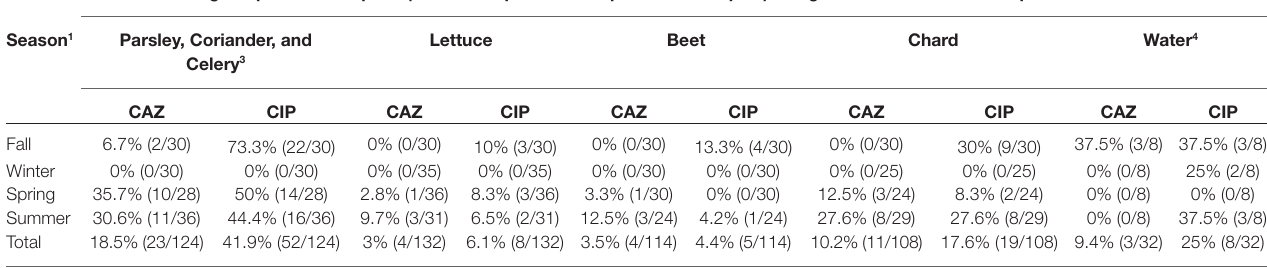
TABLE 1 | Prevalence of Enterobacterales detected with ceftazidime and ciprofloxacin added plates on vegetable and river samples. Percentage of positive samples 2 (Number of positive samples/total samples) in a given matrix obtained on plates with CAZ and